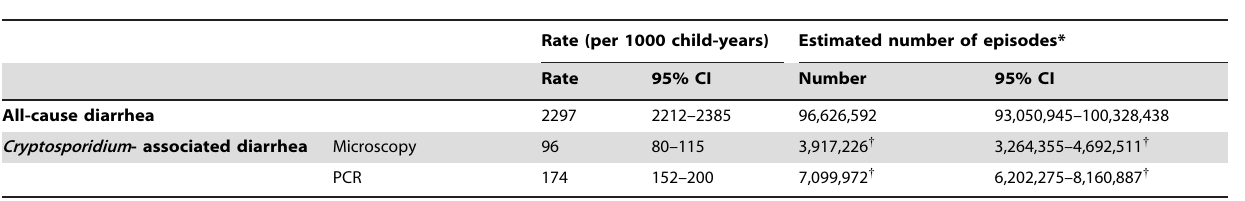
Table 2. Burden of all-cause diarrhea and Cryptosporidium -associated diarrhea in Indian children , 2 years of age.